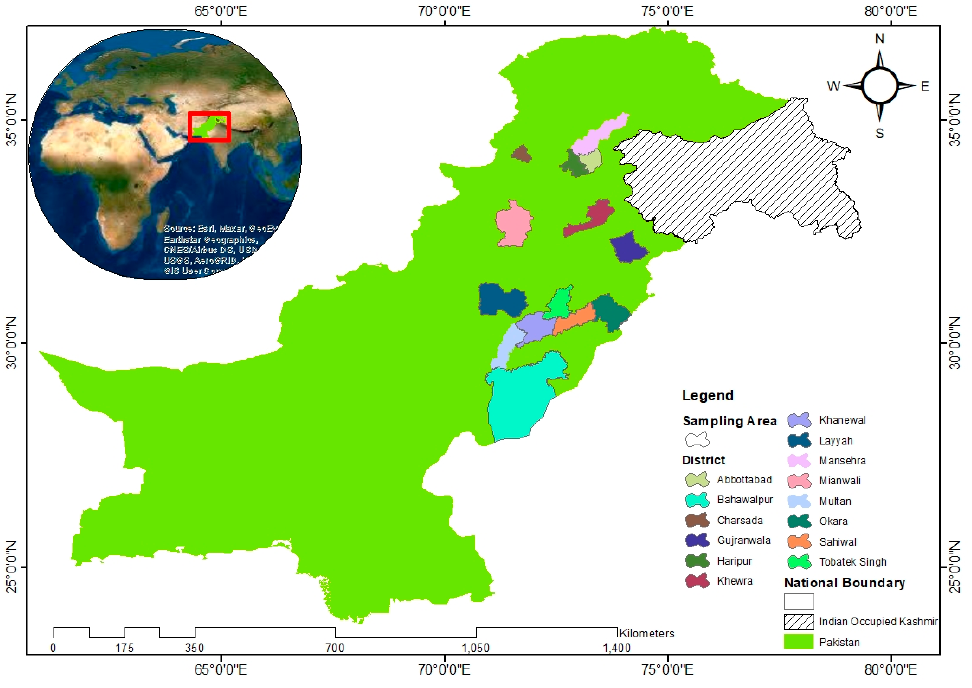
Figure 1. Soil sampling from the 14 districts of Pakistan. Table 1. Tessier et al. [22] extraction method.